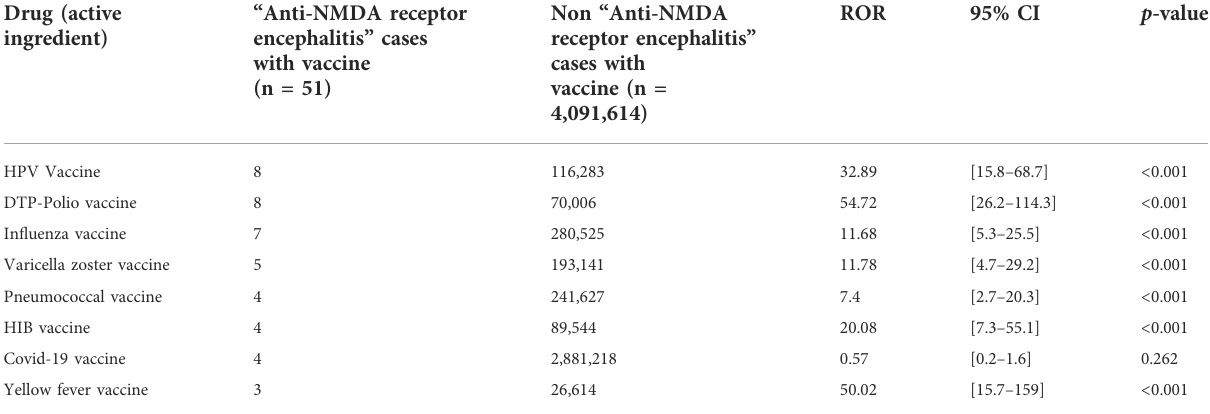
TABLE 1 Reporting odds ratios for the risk of anti-NMDA receptor encephalitis in the WHO pharmacovigilance database